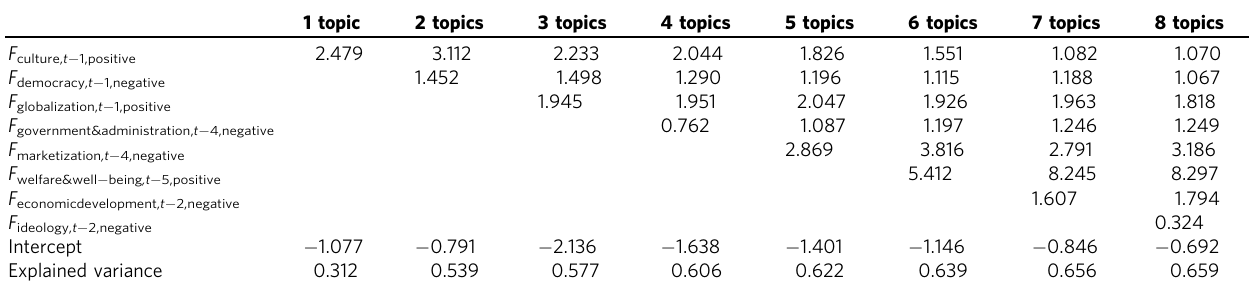
Table 2 Nested models fi tting public opinion with media sentiment.